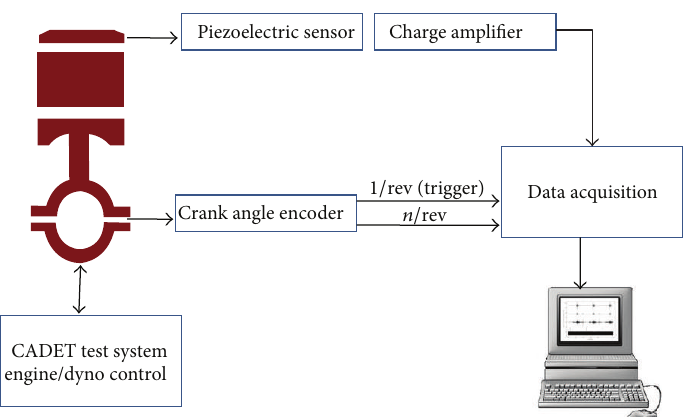
Figure 1: Schematic Engine test bench setup.